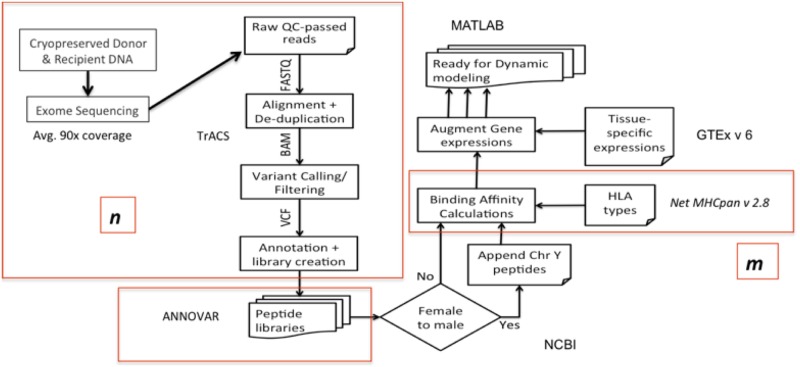
TRaCS, computational algorithm to determine tissue specific alloreactive putative peptide minor histocompatibility antigens (pmHA).Whole exome sequencing of cryopreserved donor and recipient DNA was performed, with an average coverage of 90x. The variable n refers to the number of nsSNPGVH and m to pmHA. The variable m along with protein tissue expression level was then analyzed in MATLAB to determine T cell responses.